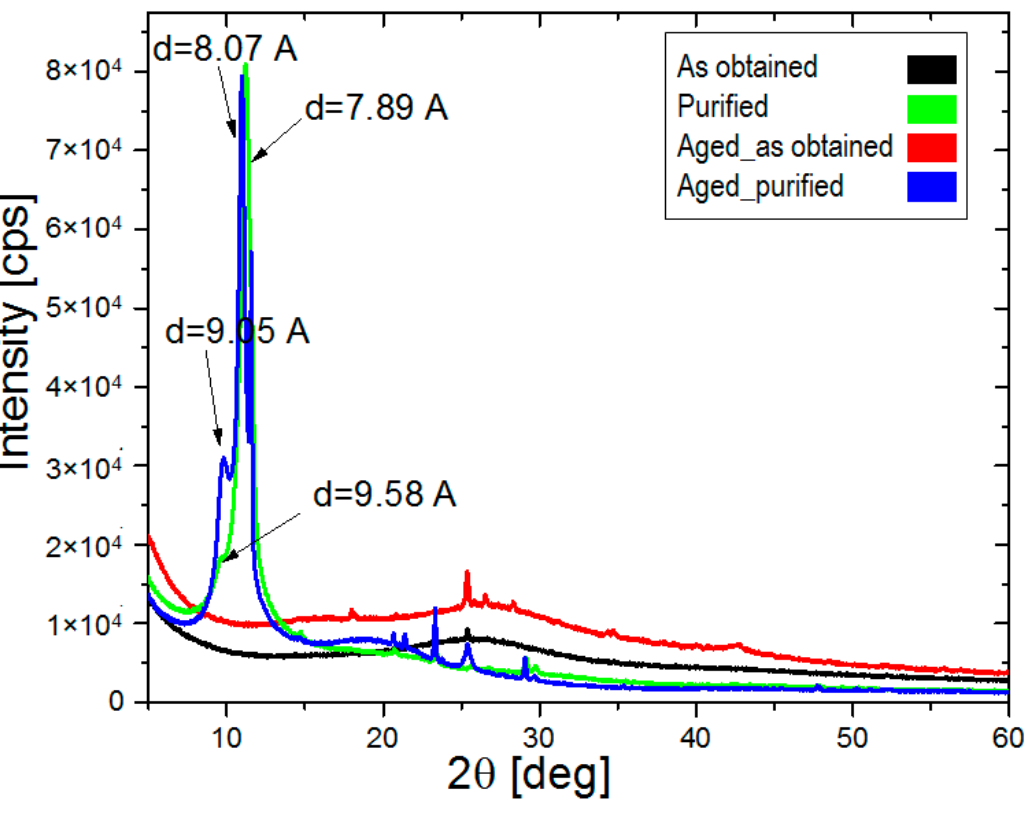
Figure 8. XRD diffractograms of synthesized materials.